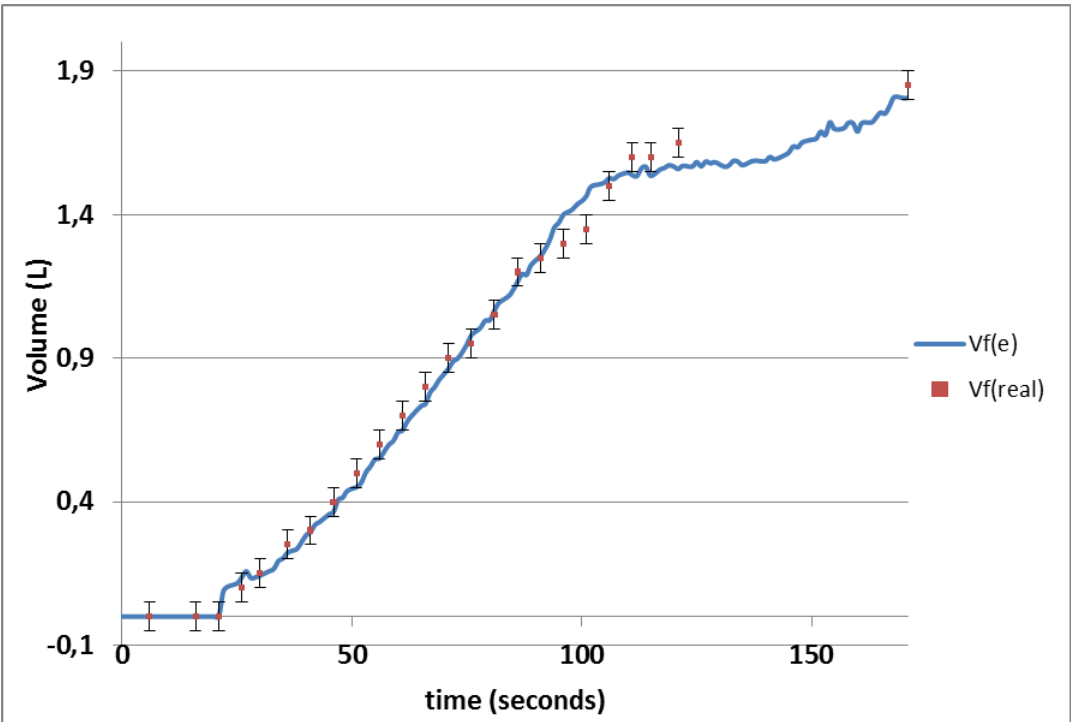
Figure 5. Manually measured volume ( Vf ( real )) and volume estimated by the electronic system and calibration model ( Vf ( e )) vs. time. The confidence intervals have been plotted for Vf ( real ) considering a manual measurement error of ±0.05